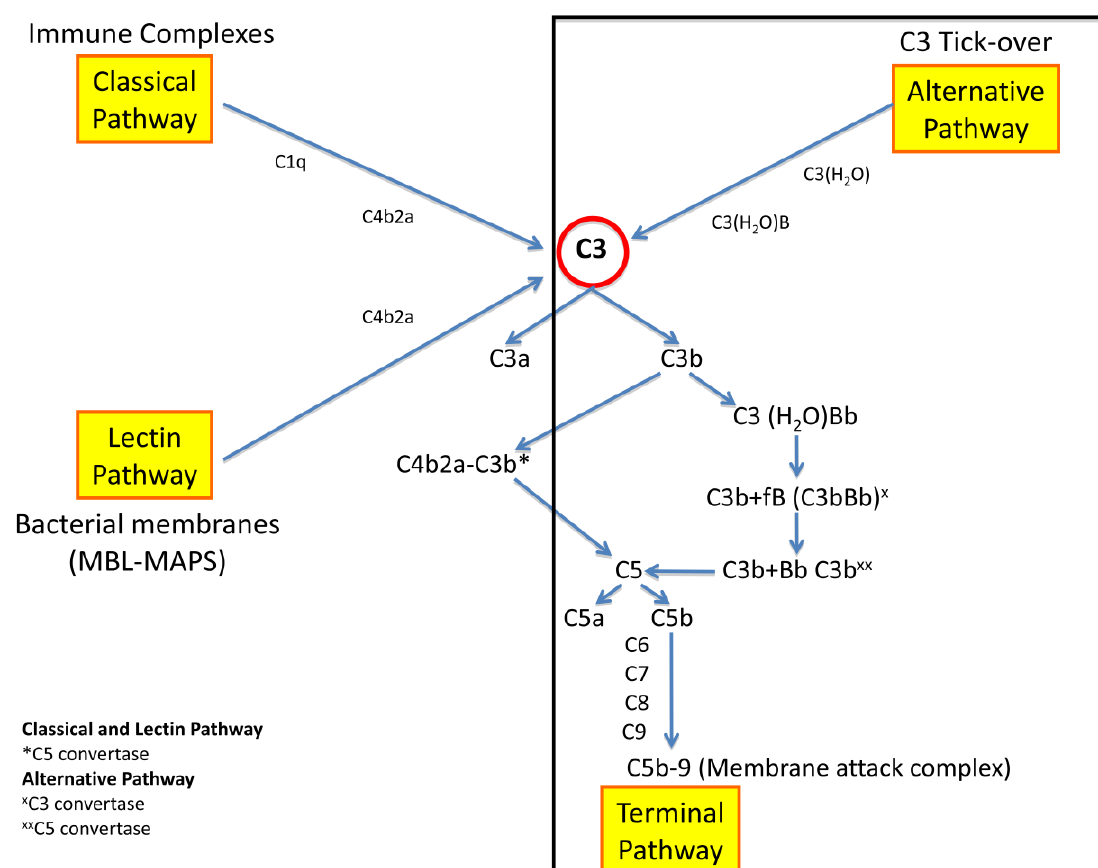
Figure 2. Complement system pathways.